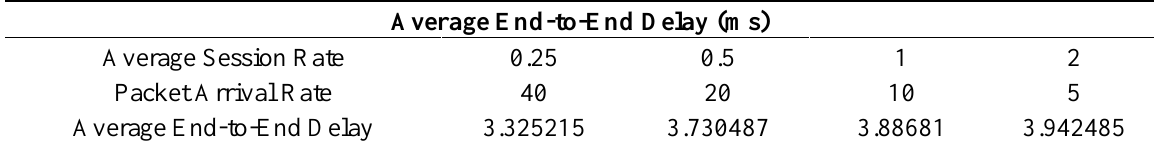
Table 8. Evaluation with different session rates (average end-to-end delay).